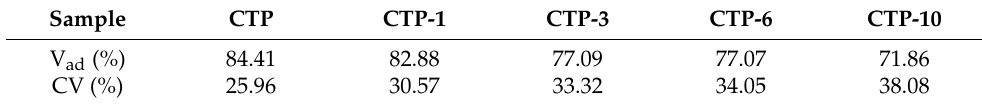
Table 1. The characteristic properties of air oxidized CTP.